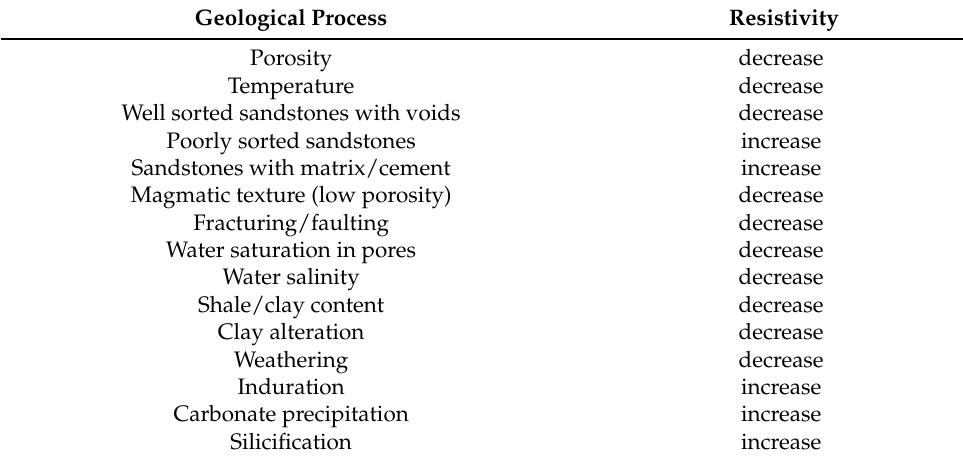
Table 2. Effect of geological processes on resistivity, after Ward [84]. Effect of rock type is illustrated in Figure